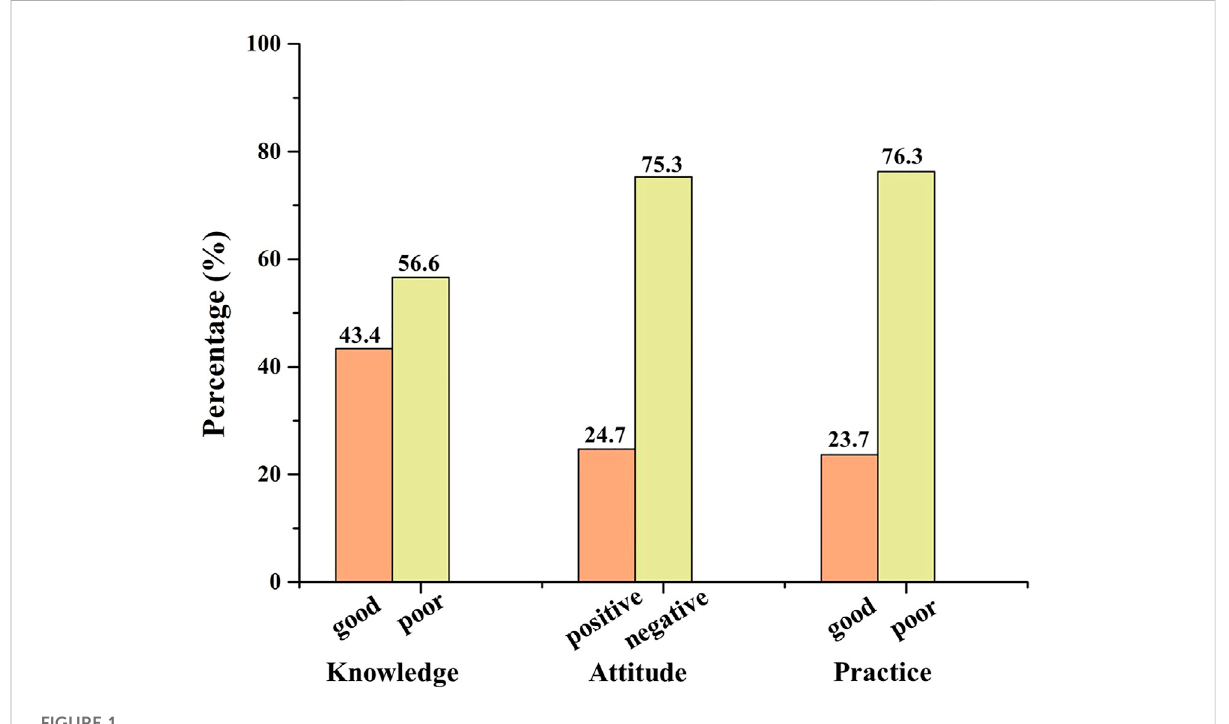
FIGURE 1 Knowledge, attitude, and practice of HCPs towards NCDP